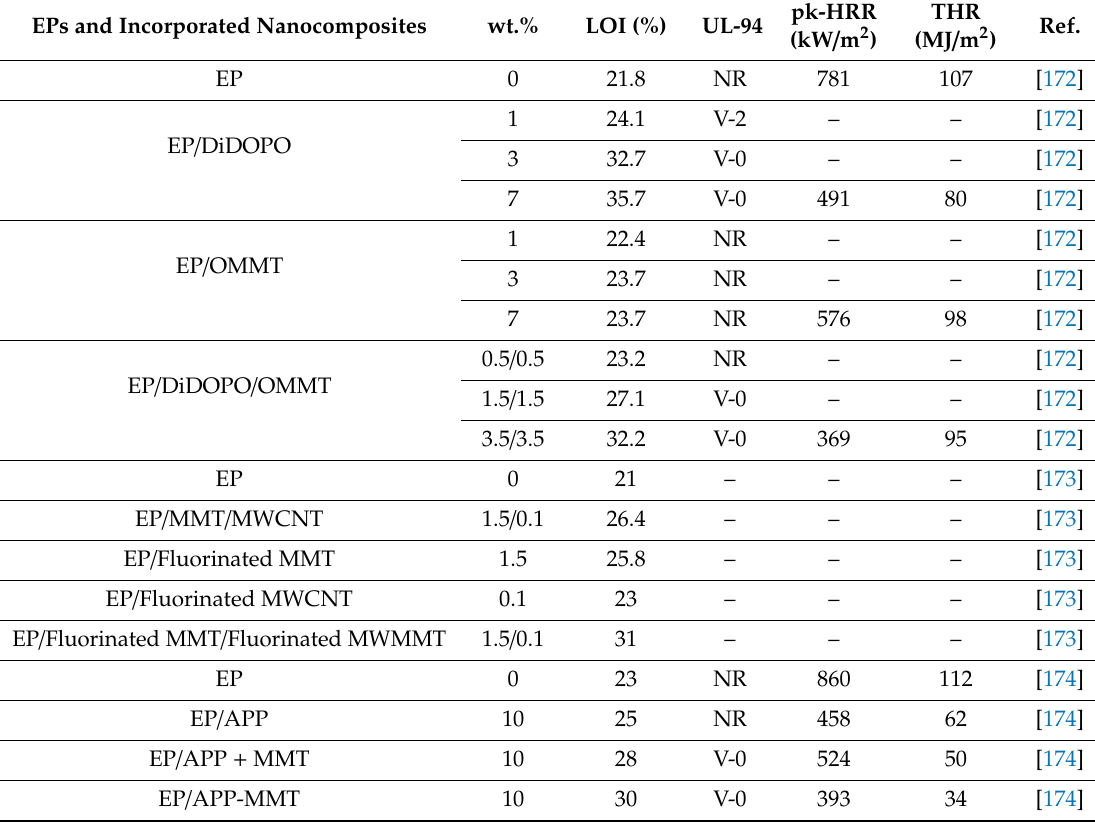
Table 5. The flame retardancy performance of epoxy containing nanocomposites. EPs and Incorporated